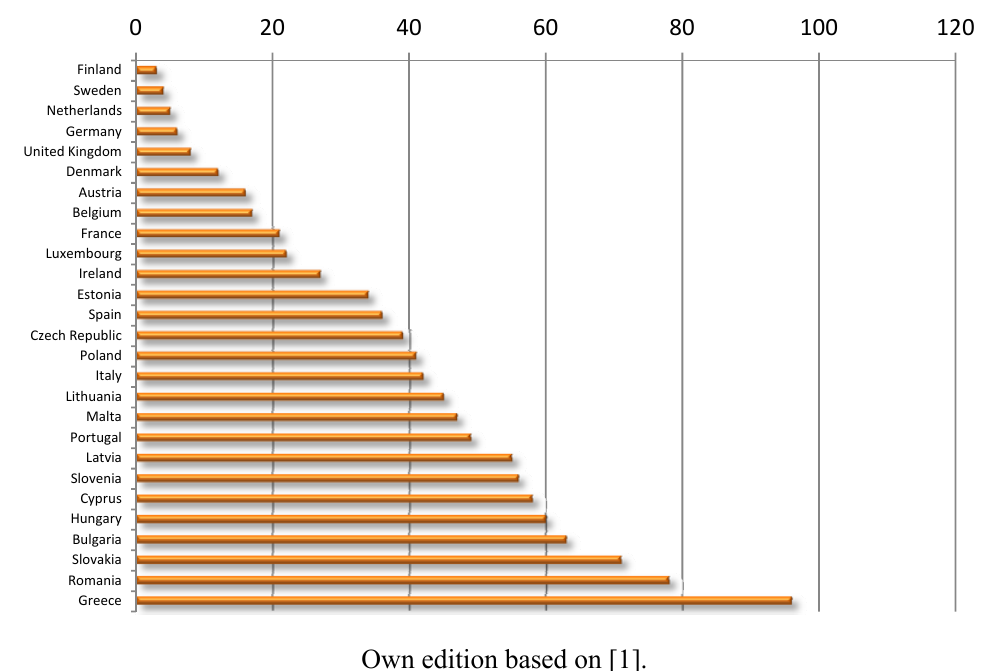
Figure 2. Global Competitiveness Report 2012–2013 overall rank of EU member states.